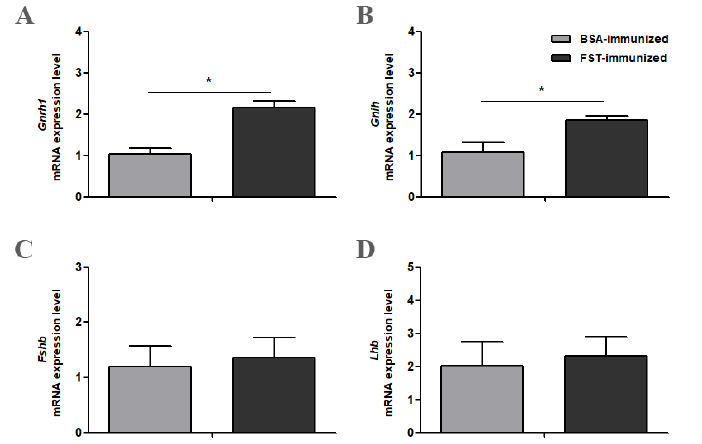
Figure 4. Gnrh1 ( A ), Gnih ( B ), Fshb ( C ) and Lhb ( D ) mRNA levels in the hypothalamus or pituitary gland in FST-immunized or the BSA-immunized control geese ( n = 6). * represents a significant difference between the two groups ( p < 0.05). Data represent mean ± SEM.